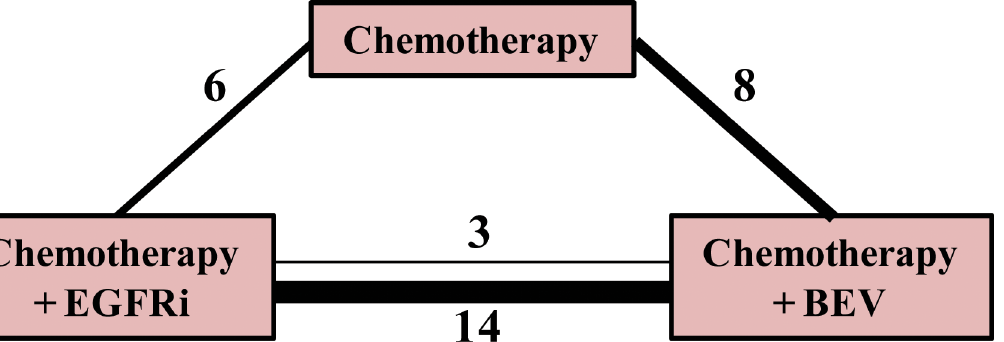
Fig 2. Network of treatment comparisons. The numbers represent the number of studies providing the comparison between the treatment regimens. The solid and dashed lines represent direct and indirect treatment comparisons of studies included in our analysis,